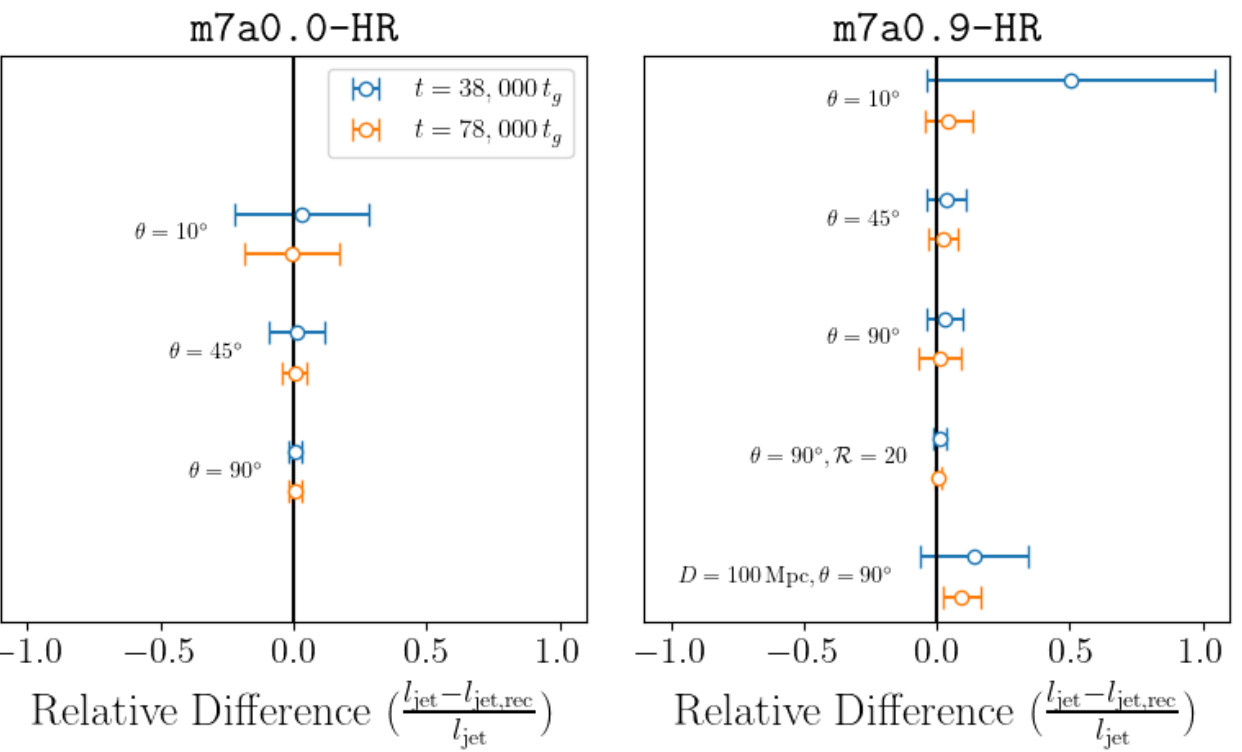
Figure 4. Here we show the relative difference (open circles) and the error within 3 standard deviations (horizontal bars) between the jet lengths obtained from the ray-traced images ( l jet ) and the reconstructed images ( l jet,rec ) . Models m7a0.0-HR ( left panel ) and m7a0.9-HR ( right panel ) are shown. For each choice of viewing angle θ , distance to the source D , and R , we show the data at t = 38,000 t g (blue) and t = 78,000 r g . We indicate the viewing angle next to each pairing of error bars. For each model, except where explicitly indicated to be otherwise, we show D = 10 Mpc and R = 1. In general, there is a very small relative difference when the jet is viewed edge on. As the viewing angle approaches face on or the jet is placed at a larger distance, the relative difference increases along with the error. In all but one image, even when the relative difference shifts away from zero, the zero relative difference line is within 3 standard deviations, which suggests excellent agreement between jet lengths derived from the raw ipole and reconstructed